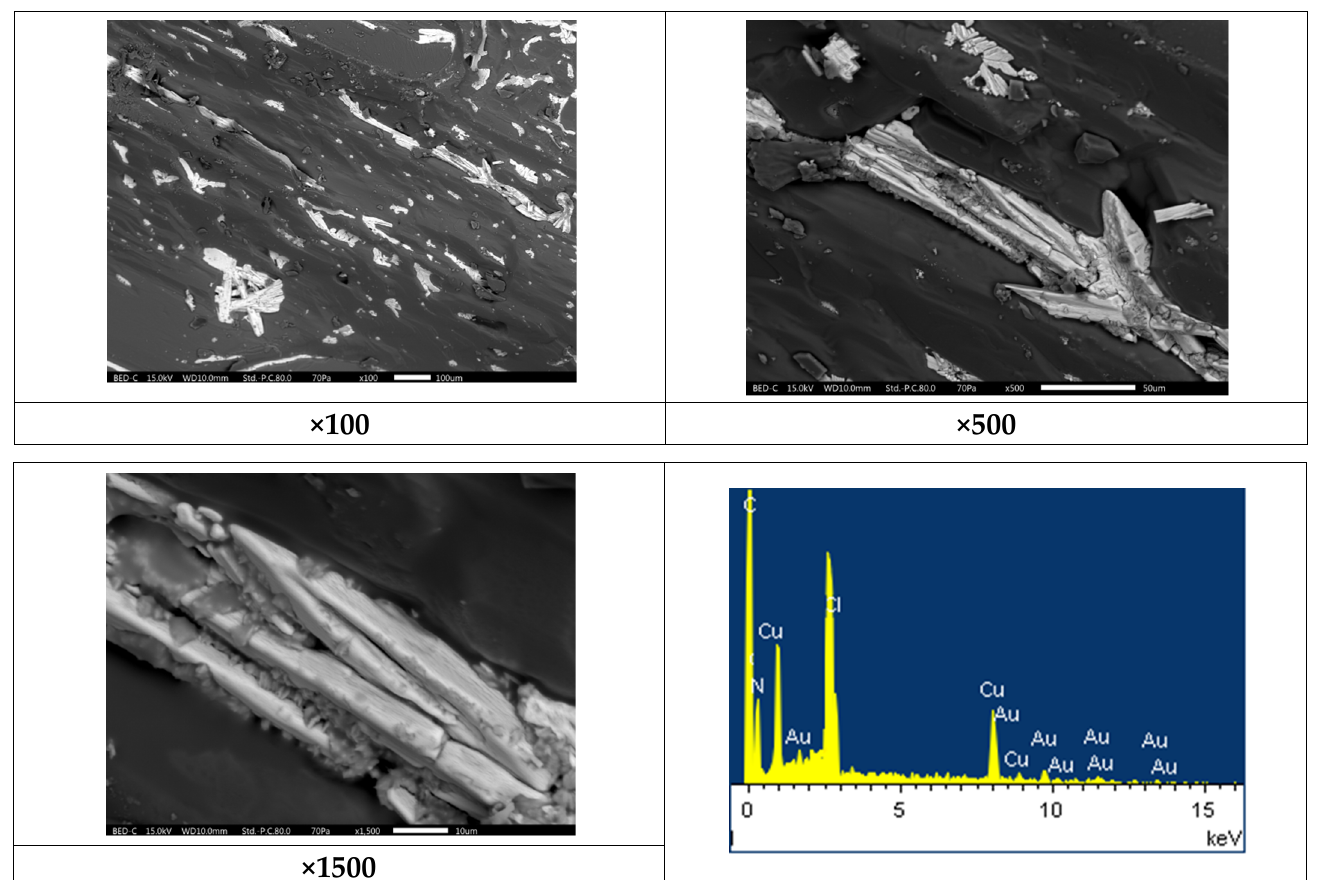
Figure 1. Experimental and theoretical powder diffractograms.